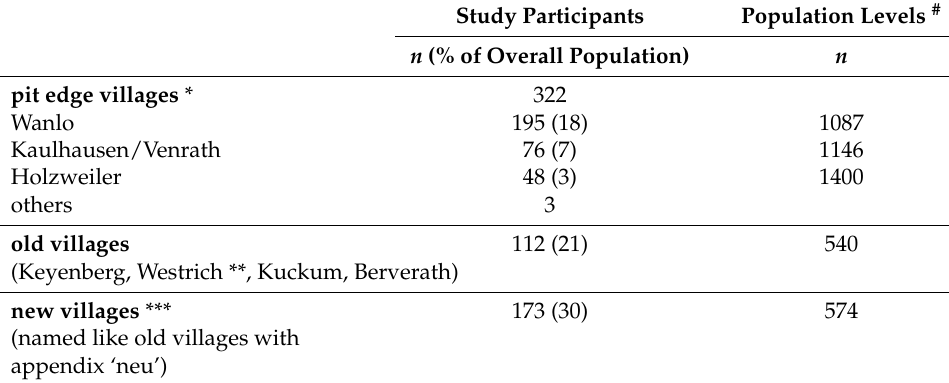
Table 1. Overview of Study Participants and Population Levels at Garzweiler Open-Pit